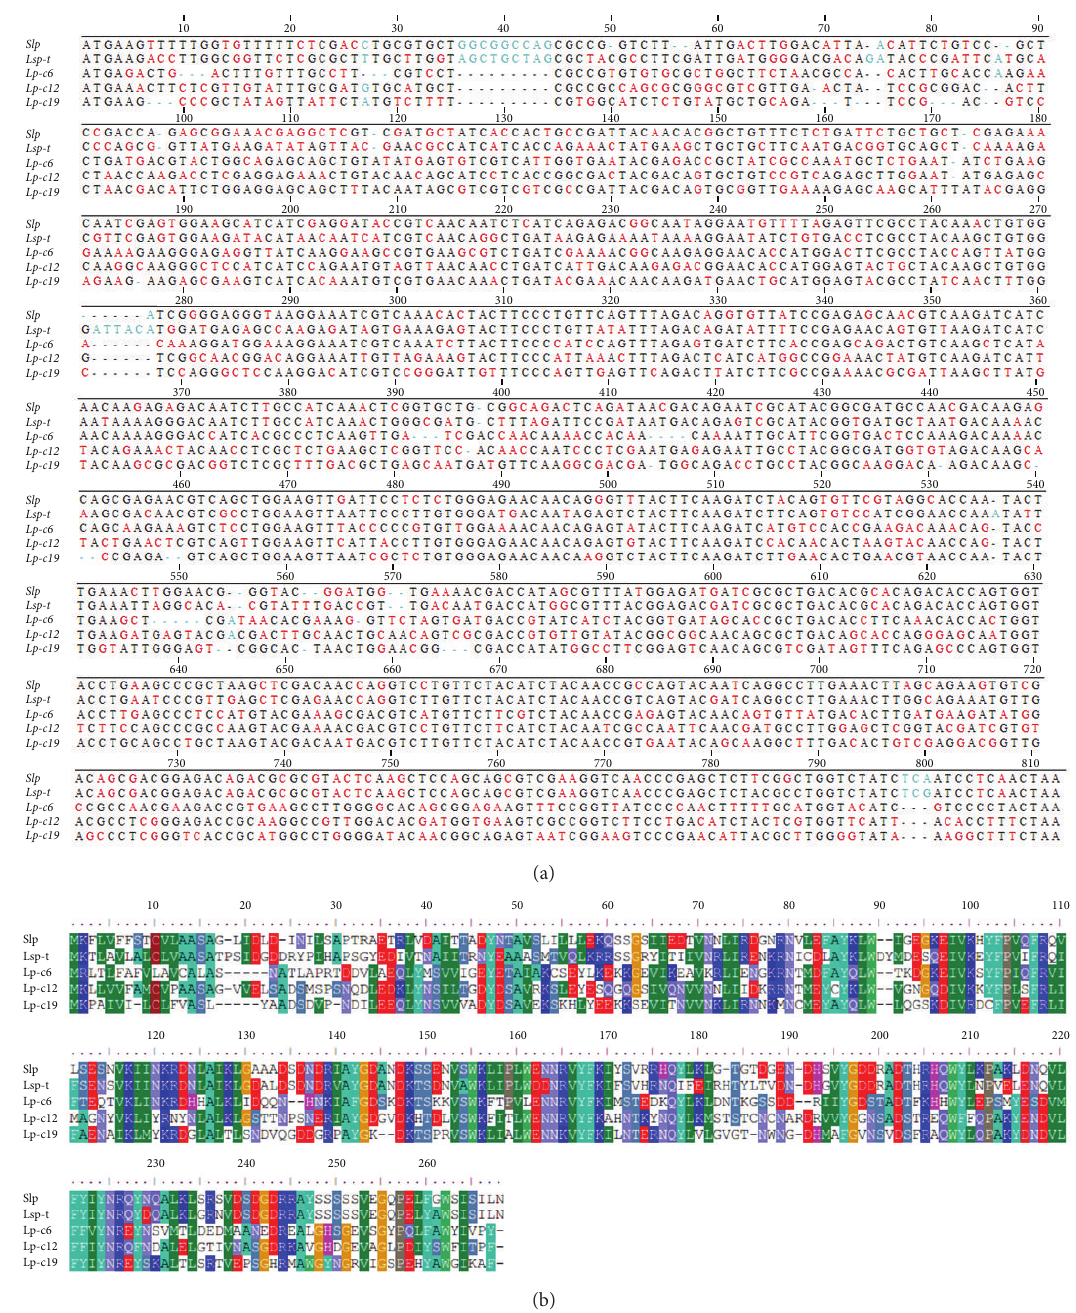
Figure 1: Comparative homology analysis of DNA sequences (a) and amino acid residues (b) of silkworm 30K proteins. Slp: silkworm Slp protein; Lsp-t: silkworm Lsp-t protein; Lp-c6: silkworm lipoprotein 30Kc6; Lp-c12: silkworm lipoprotein 30Kc12p; Lp-c19: silkworm lipoprotein 30Kc19G. Conserved domains of lipoprotein-11: Slp (amino acids 6–261), Lsp-t (amino acids 6–266). Conserved amino acid residues are marked as same